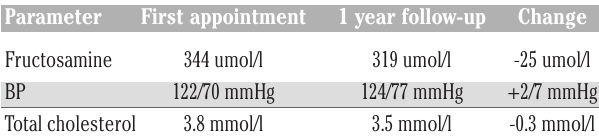
Table 2. Performance of Key Care Processes at all Joint Clinic reviews compared to National Diabetes Audit for England. Care Process